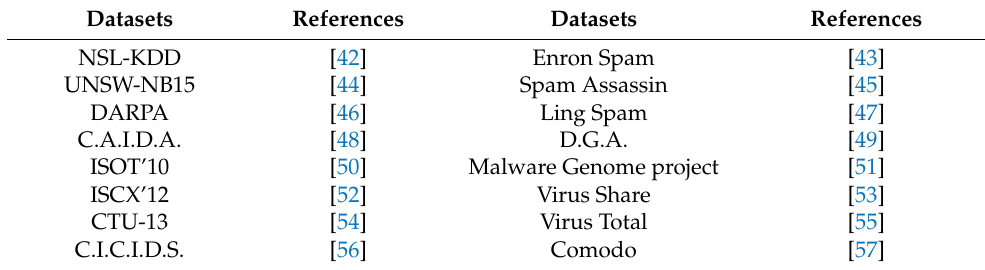
Table 3. Datasets in the domain of